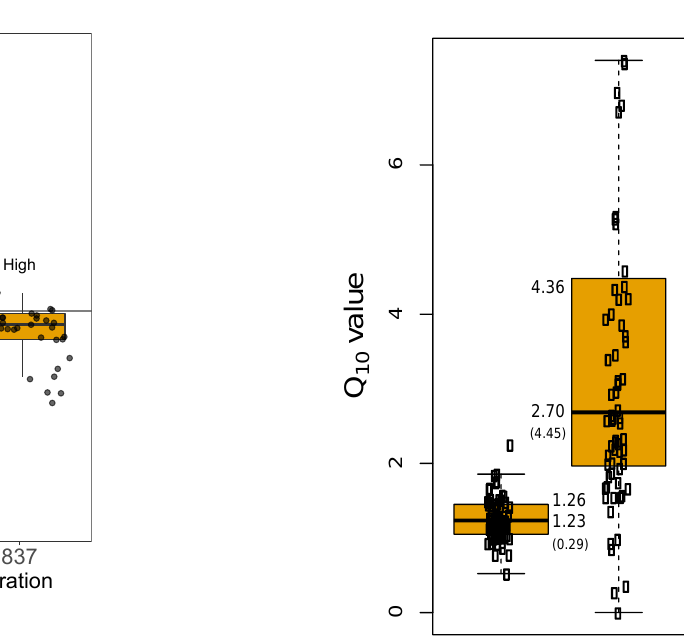
Figure 5. Difference in the COS hydrolysis rate constants of moist soils, calculated using the production rates estimated from dried soils ( k recal with P dry ) and moist soils ( k moist with P moist ), as a function of three different atmospheric COS concentrations in the outlet. Each grey point represents one soil replicate, the red box shows the lower, median and upper quartile values, the whiskers in- dicate the range of variation in the difference, and the box width represents the range of variation in the net COS flux measured for the different soils.